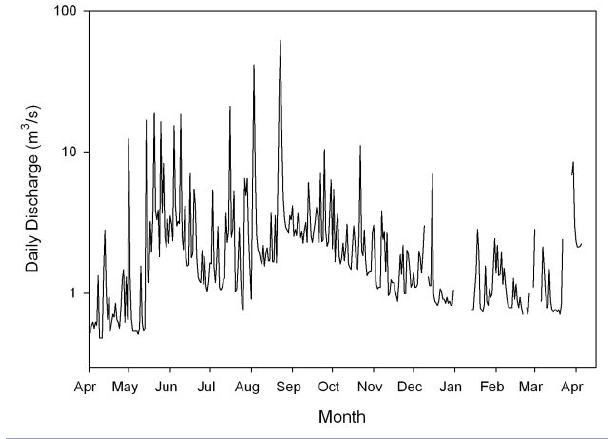
Fig. 3 . Daily discharge at the Río Piedras based on records from U.S. Geological Survey station 50048770 at El Señorial station, which is located 60 m.a.s.l., drains 19.4